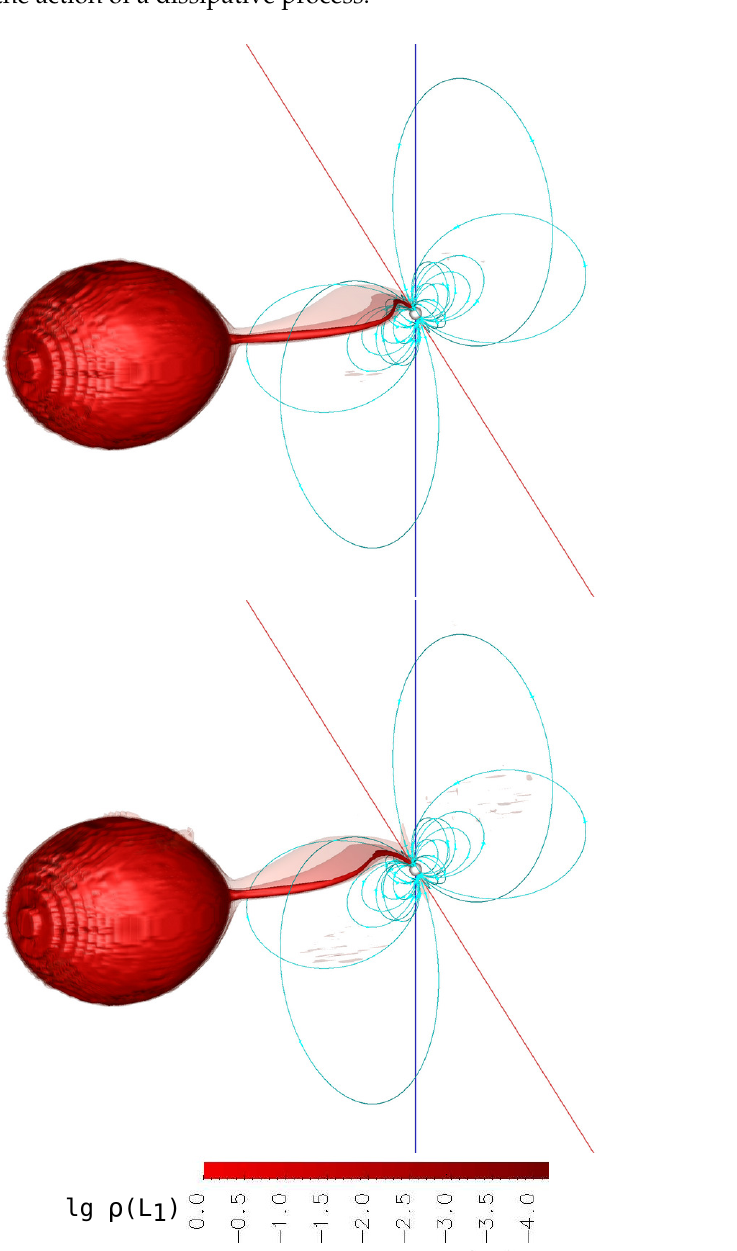
Figure 4. The result of three-dimensional numerical modeling of the flow structure in the synchronous polar V808 Aur for Variant 1 ( upper panel) and Variant 2 ( lower panel). The iso-surfaces of the decimal logarithm of the density in units of ρ ( L 1 ) are shown. The accretor is represented as a white sphere. The blue vertical line passing through the accretor coincides with its axis of rotation, and the inclined green line coincides with its magnetic one. The binary system is shown at the point of view of an Earth observer at the orbital phase